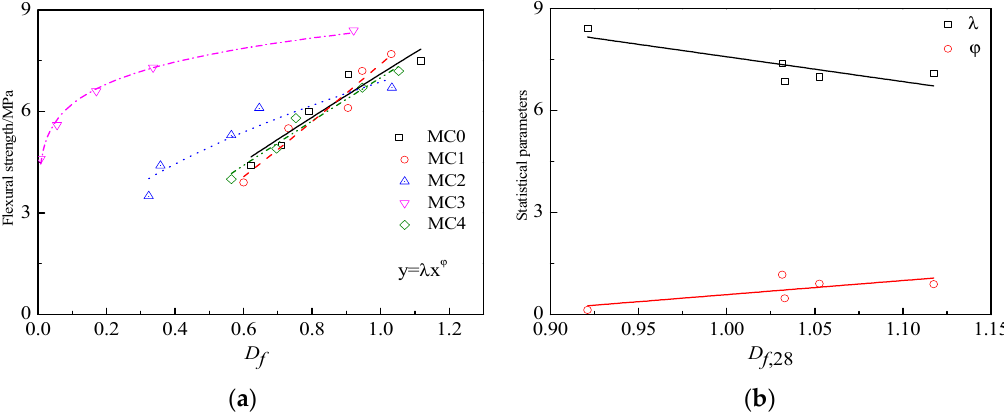
Figure 6. The relationship between flexural strength of NCM and statistical parameters and D f : ( a ) R f with D f ; ( b ) statistical parameters with D f ,28 .